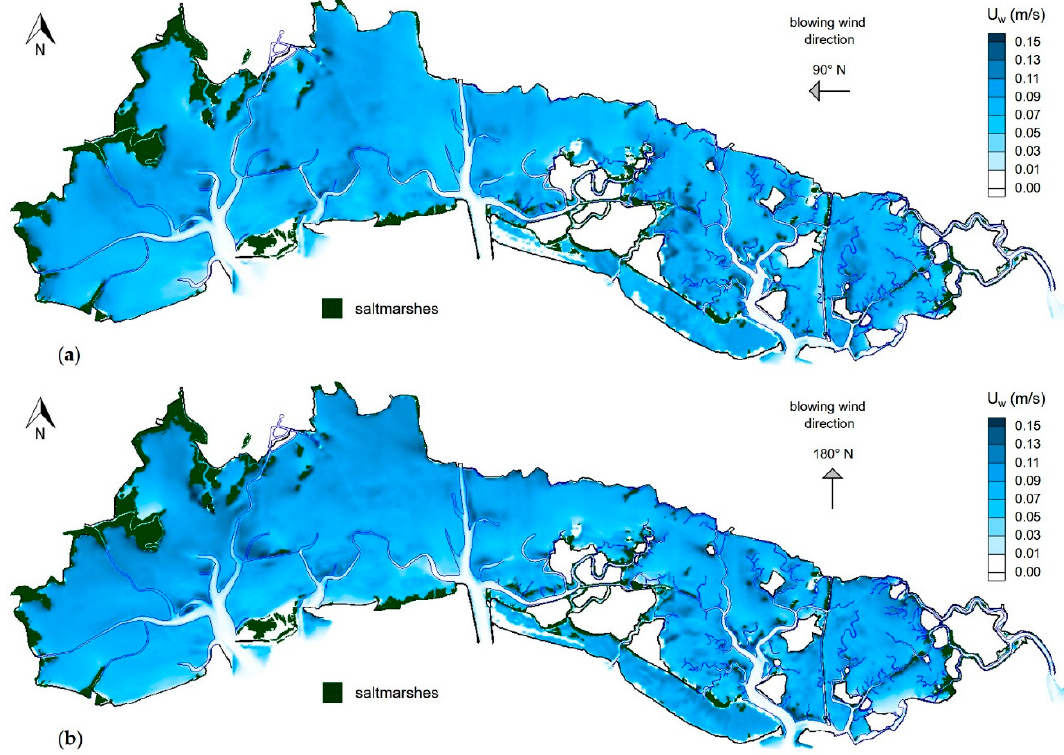
Figure 13. Simulated maximum bottom orbital velocities for wave motion generated by wind blowing from: ( a ) East; ( b ) South.